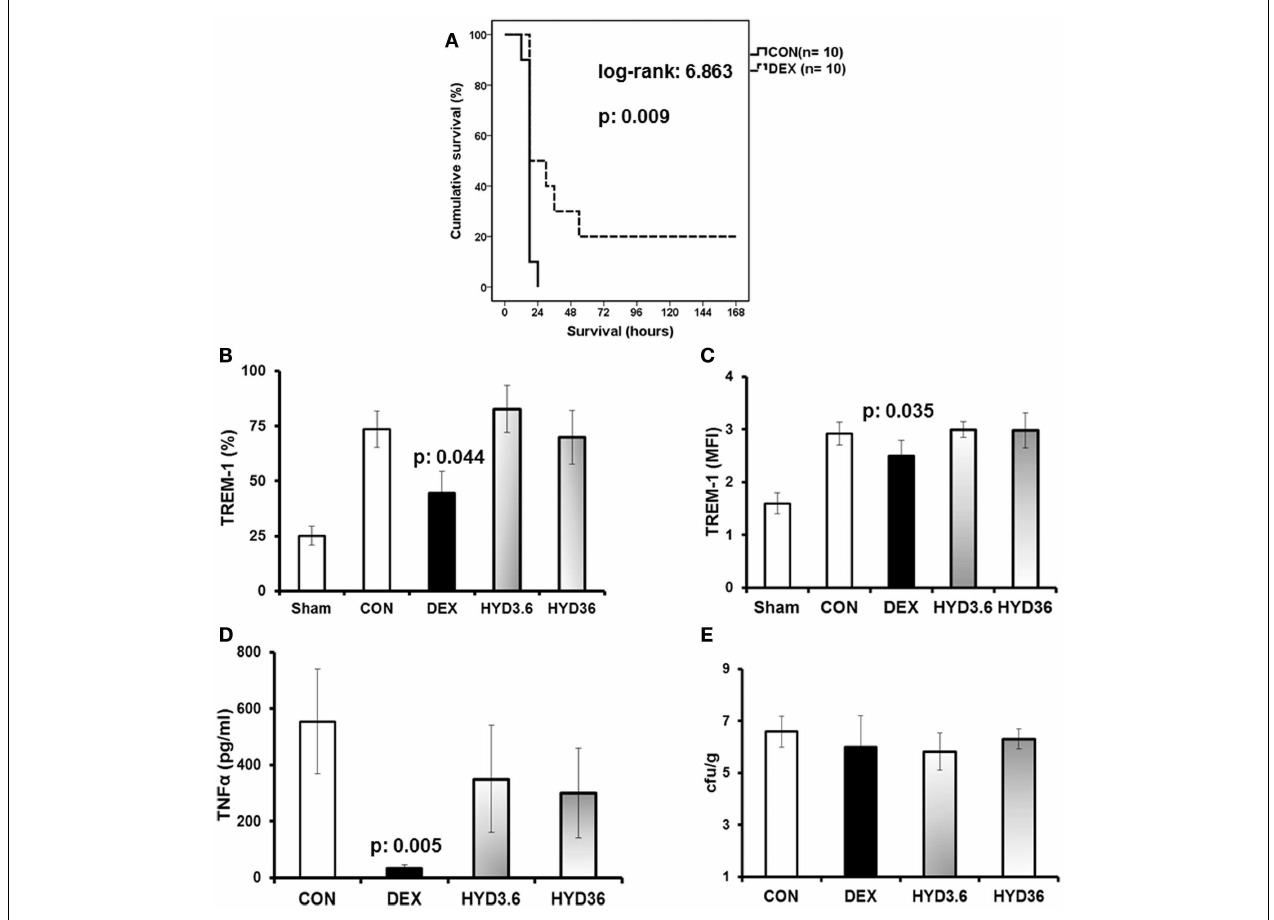
ofTREM-1 on circulating neutrophils at animal sacrifice, (D) shows serum concentrations ofTNF α at animal sacrifice, and (E) shows liver bacterial loads. Results from (B–E) refer to six mice per group. Data in uninfected mice are also provided [Sham in (B,C) ]. Data forTREM-1 are shown as percent of neutrophils expressingTREM-1 (B) or expressed asTREM-1 MFI for neutrophils (C) . P values indicate significant differences compared to